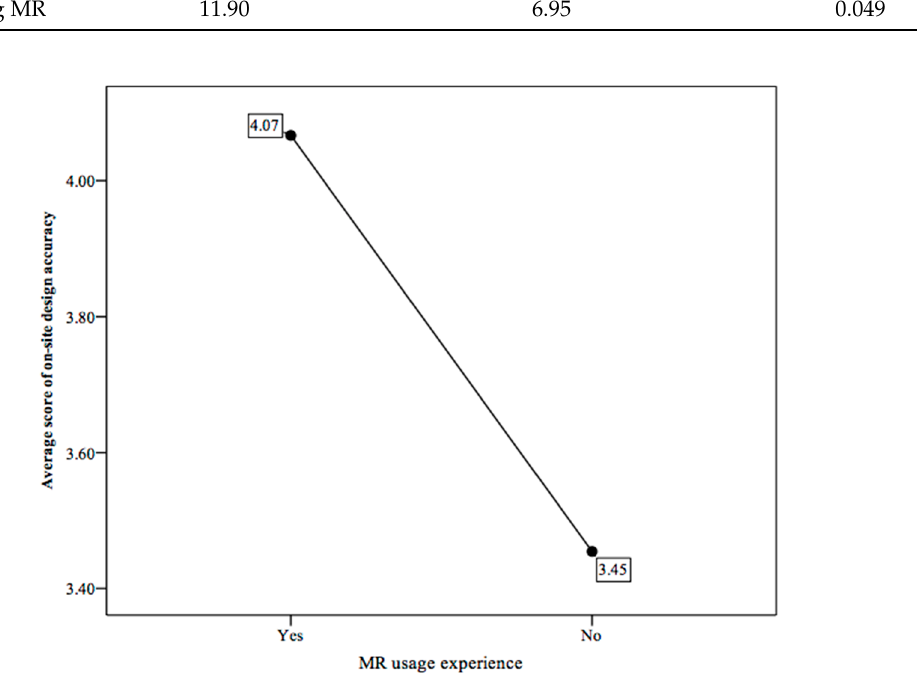
Table 3. The Kruskal–Wallis test for different MR usage experience groups in on-site design accuracy using MR. Mean Ranks of Scores for the MR Usage Experience Groups